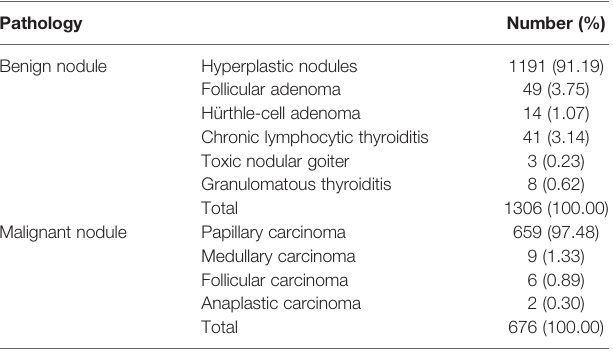
TABLE 2 | Distribution of pathologies of the thyroid